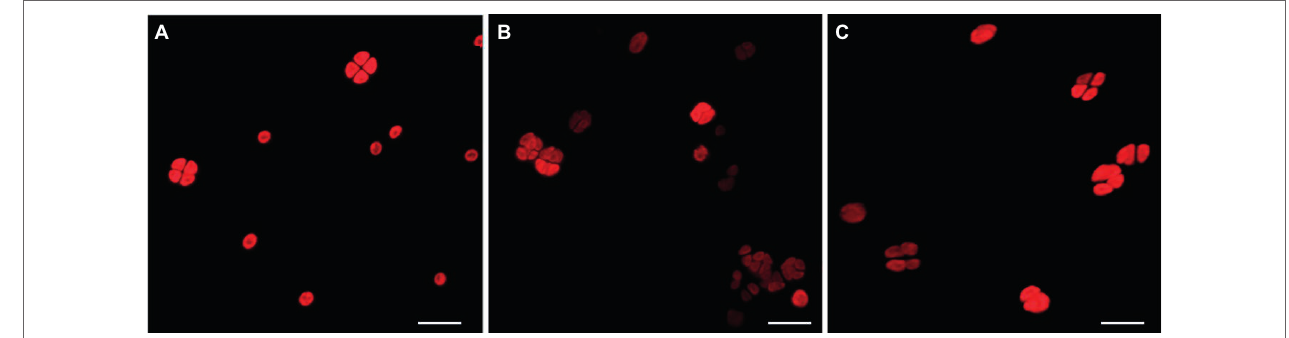
FIGURE 2 | CLSM images of photosynthetic pigment autofluorescence. Cells from liquid cultures (A) ; dried biofilms (B) ; and dried-UV-irradiated biofilms (C) . Scale bar: 10 μm.